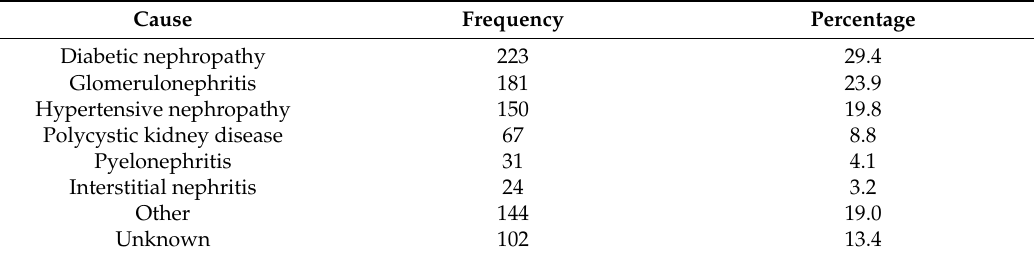
Table 2. Causes of chronic kidney disease.